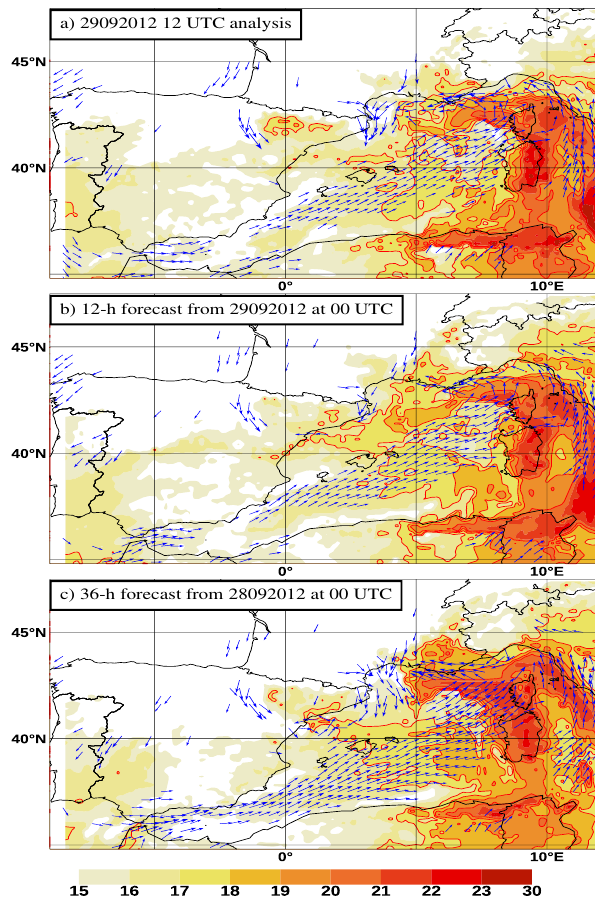
Figure 26. Wind at 925hPa (blue arrows in excess of 20ms − 1 ) and wet bulb temperature ( ◦ C; colour scale) at 925hPa from AROME- WMED analyses (a) , 12h (b) and 36h (c) forecast